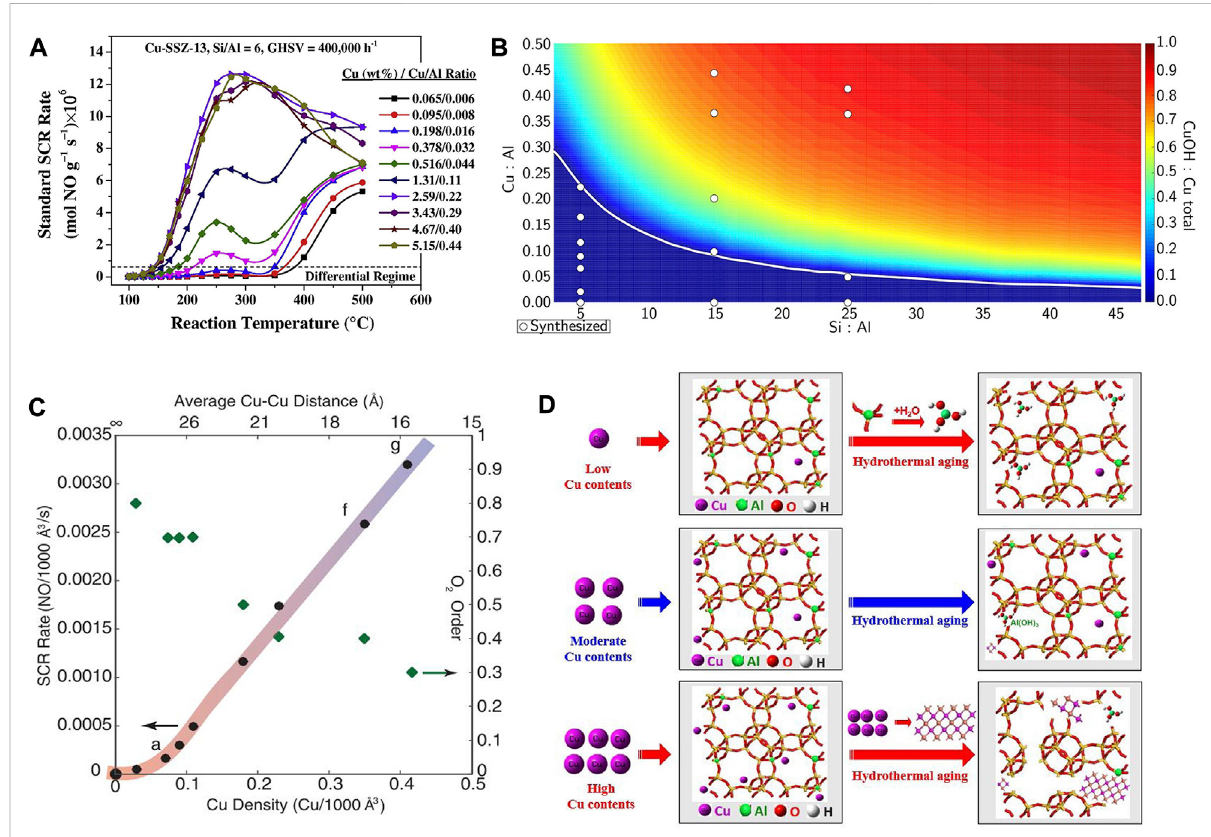
FIGURE 5 The effect of Cu content or Cu/Al ratio on the active sites and SCR performance of Cu-SSZ-13 catalysts. (A) Standard SCR rates as a function of temperature for Cu-SSZ-13 catalysts with various Cu-loadings and Cu/Al ratios. Reproduced with permission Gao et al. (2014), Copyright 2014, Elsevier Publishers. (B) Predicted Cu site compositional phase diagram versus Si:Al and Cu:Al ratios. Reproduced with permission Paolucci et al. (2016b),Copyright2016,AmericanChemicalSociety. (C) StandardNO x SCRrates(pervolumecatalyst;473 K;measuredinadifferentialreactor byusingagasmixturerepresentativeofpracticallow-temperatureapplication,including2.5%H 2 O)andapparentO 2 ordersmeasuredonCu-CHA-X samples (Si/Al = 15) of increasing Cu ion density. Reproduced with permission Paolucci et al. (2017), Copyright 2017, American Association for the Advancement of Science. (D) The deactivation mechanism of hydrothermal aging of Cu-SSZ-13 with different Cu contents. Reproduced with permission Shan et al. (2020), Copyright 2020, Elsevier